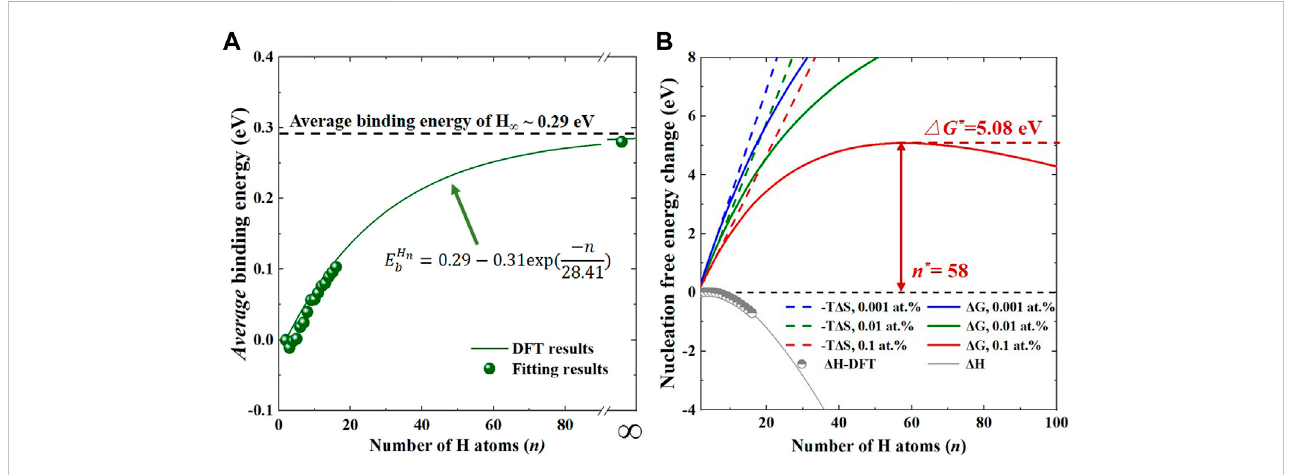
FIGURE 2 (A) The average binding energy of a planar H cluster in W as a function of cluster size. The fi tting curve (solid green line) using a simple exponential function is also provided; (B) Nucleation free energy changes of H n clusters at 300 K with different hydrogen concentrations (0.001/0.01/0.1